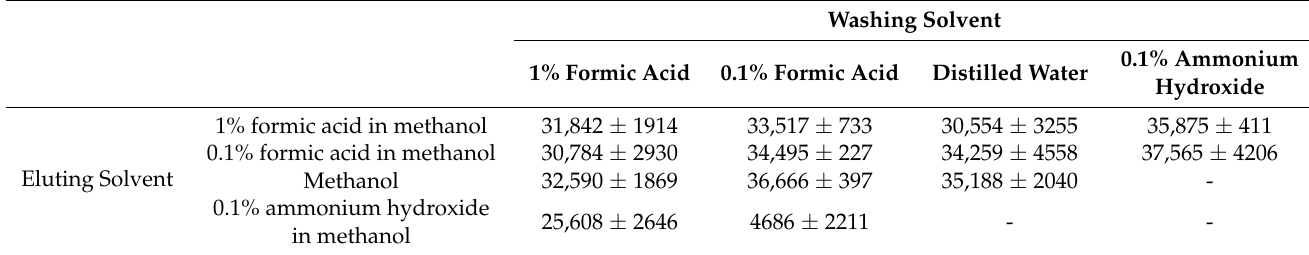
Table 1. The effect of washing solvent and eluting solvent by SPE method on the peak area of nafamostat (100 ng/mL) in the rat plasma (mean ± SD, n = 3).